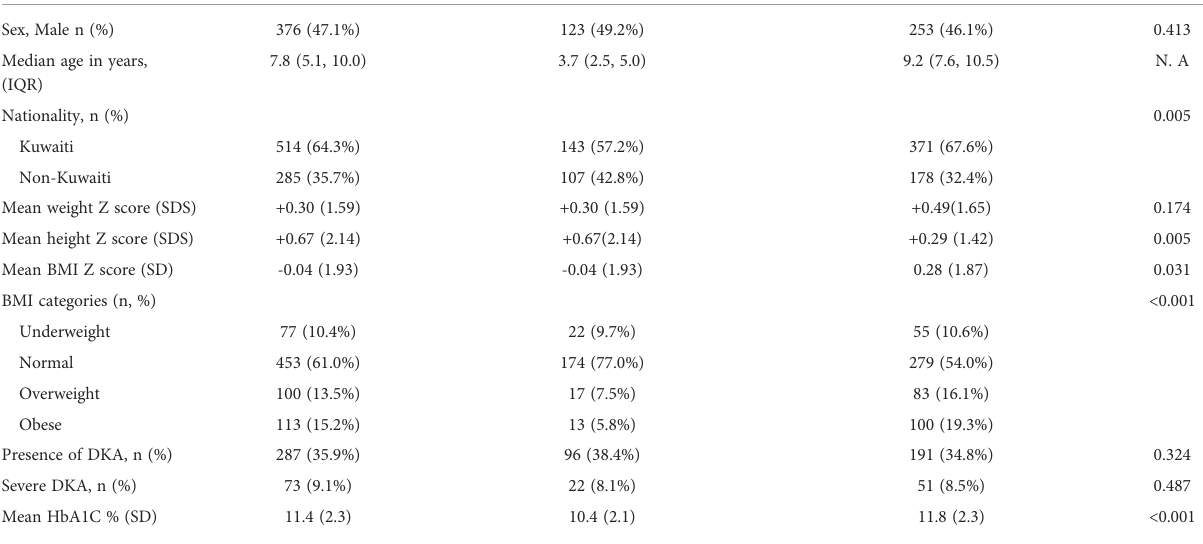
TABLE 1 Baseline characteristics of children older than 6 years at diagnosis of T1D compared to younger children during the period 2011-2017.